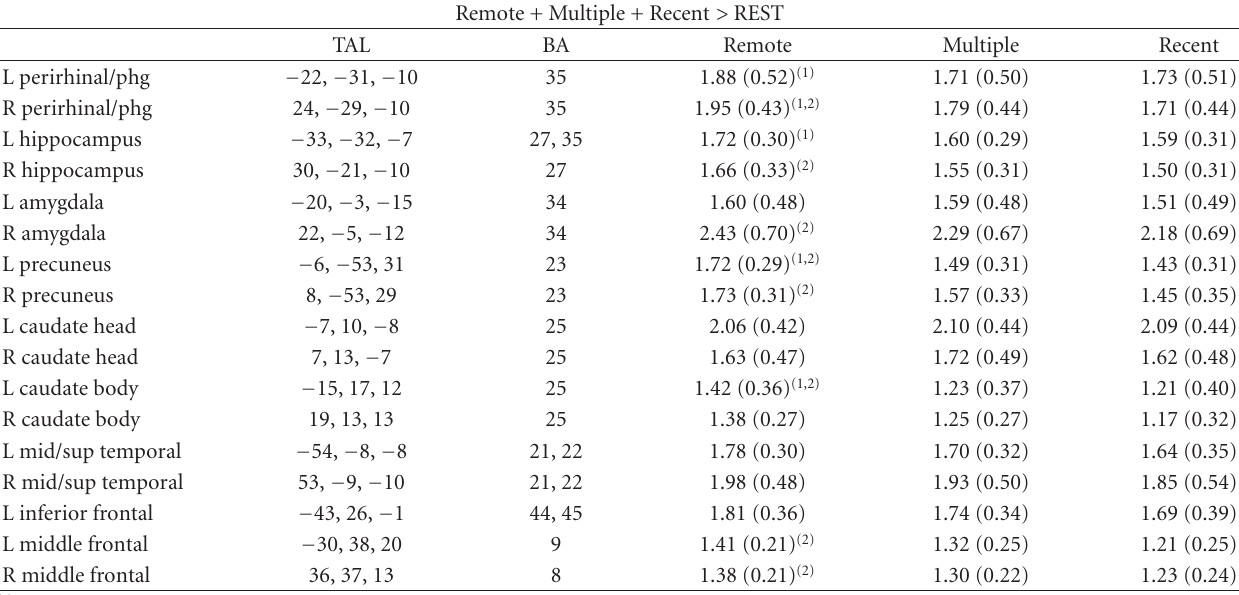
Table 3: Mean e ff ect sizes (standard error of the mean) for the three retrieval conditions compared to REST at P < .01. Noted are Talairach coordinates (TAL) and Brodmann’s areas (BAs) referencing the center of the activation cluster. The results of various paired sample t -tests are also reported below the table (parahippocampal gyrus, phg; middle, mid; superior, sup). No other paired comparisons were significant.